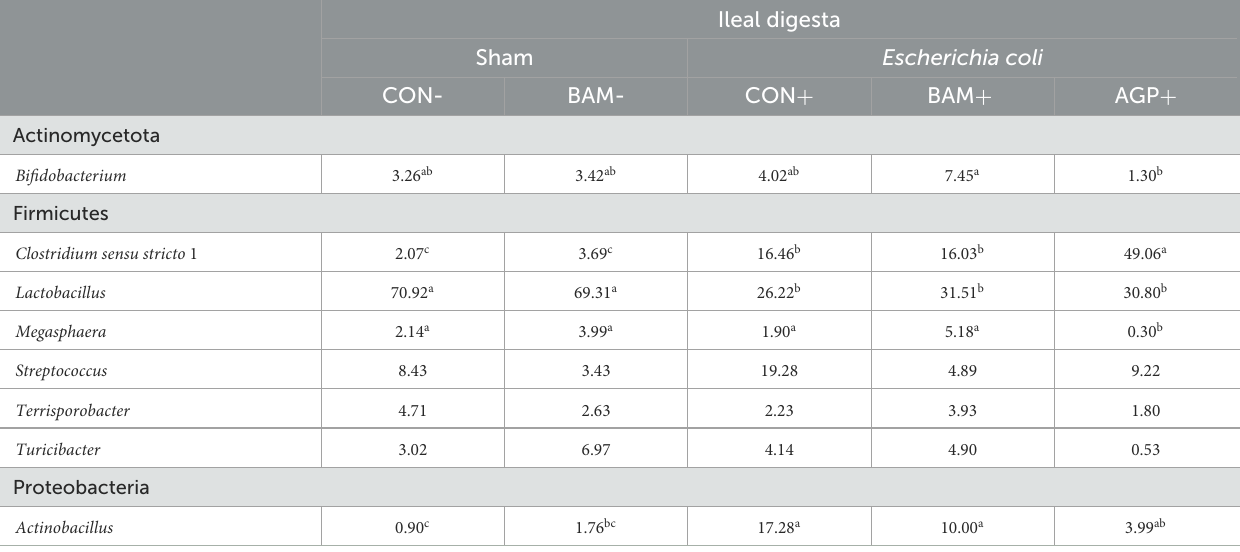
TABLE 7 Relative abundance (%) of most abundant genera from Firmicutes and Proteobacteria in ileal digesta of weaned pigs fed a control (CON) diet or diets supplemented with Bacillus amyloliquefaciens (BAM) or antibiotics (AGP).